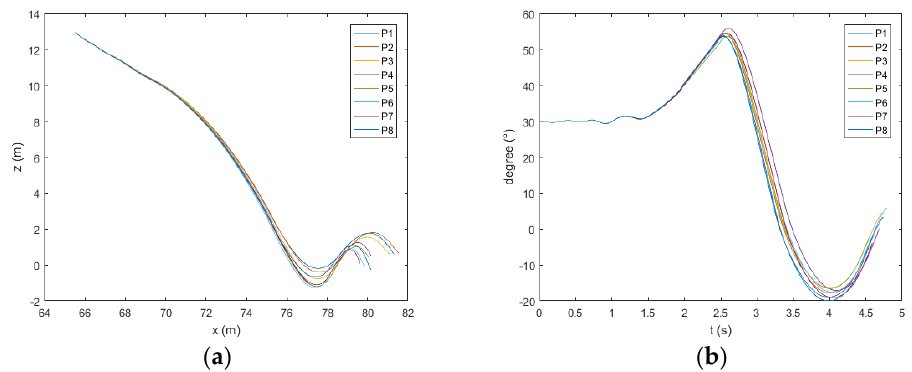
Figure 13. Trajectory ( a ) and pitch ( b ) of the lifeboat freefall when the wave height is 1 m.